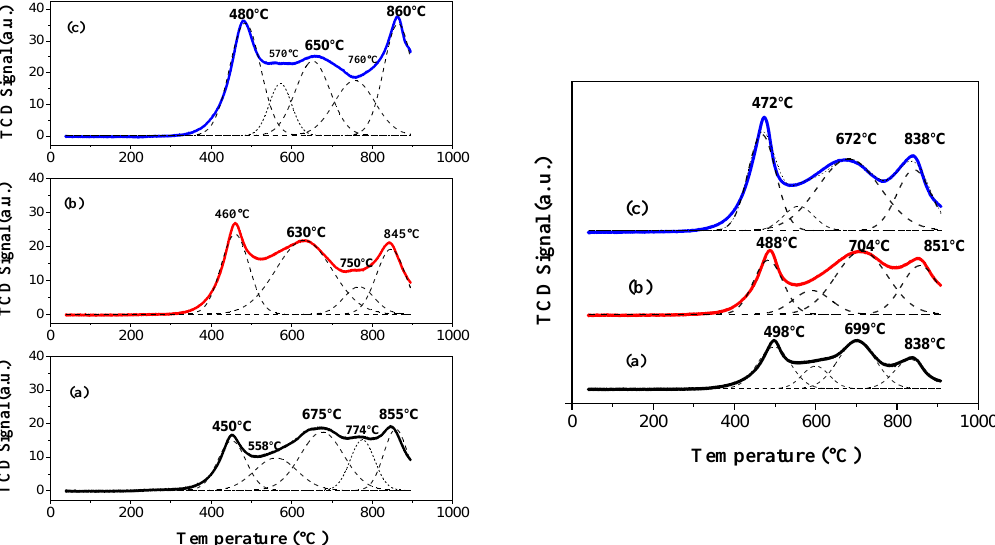
Figure 3. TPR profiles for the Mo/AT2 catalysts ( left ) and the CoMo/AT2 catalyst ( right ) with different Mo loadings: ( a ) 10, ( b ) 12, and ( c ) 15 wt.%.